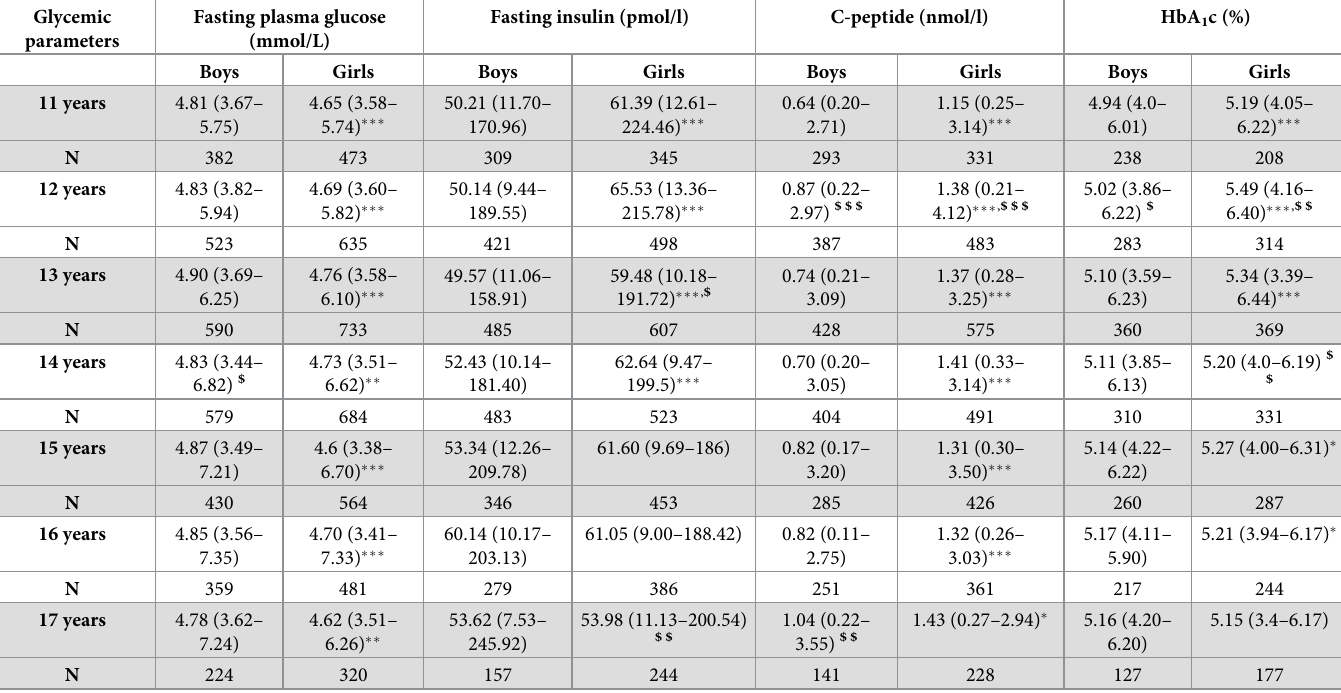
Table 2. Variation of glycemic parameters with gender across different ages during